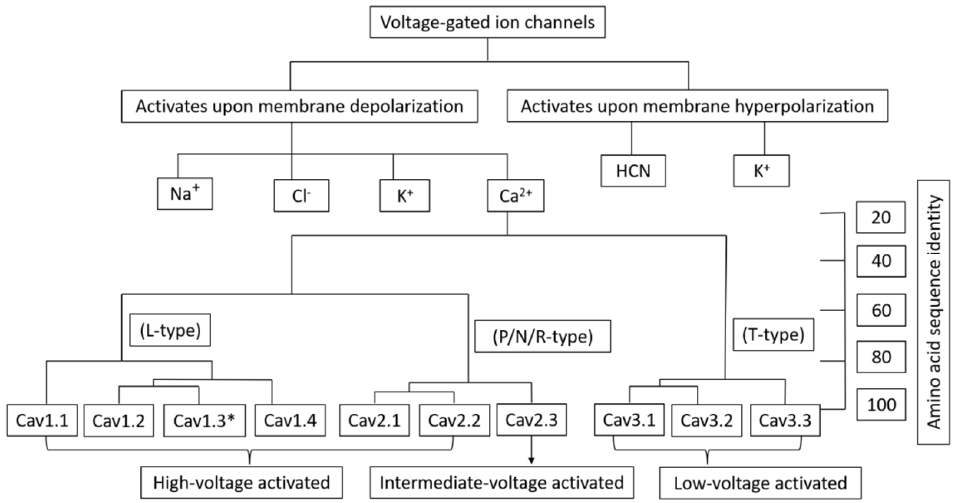
Figure 1. Classification of voltage-gated ion channels based on the activation potential. *Cav1.3 channel isoforms are the exception in L-type channels as they can also be activated at low-voltages.